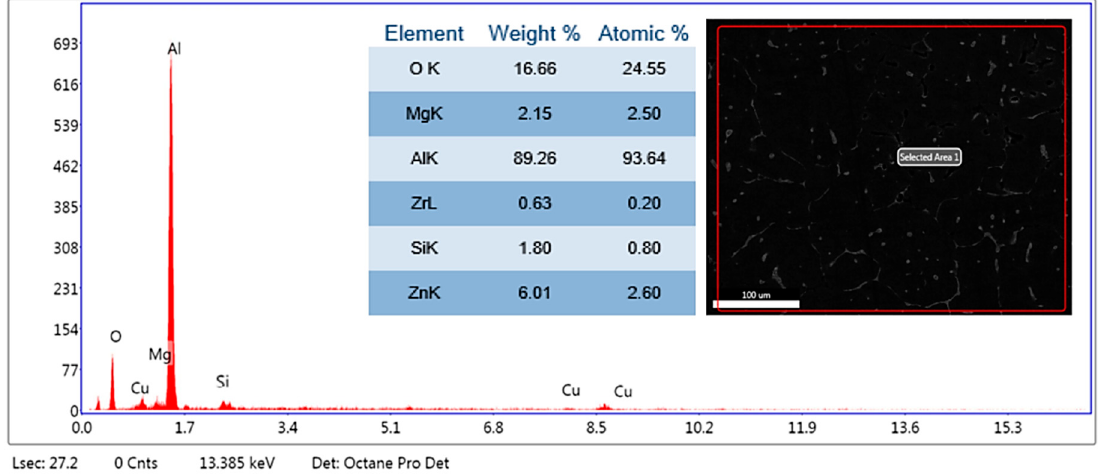
Figure 7. EDS of AA 5083/5 wt.% SiC/4 wt.% fly ash.